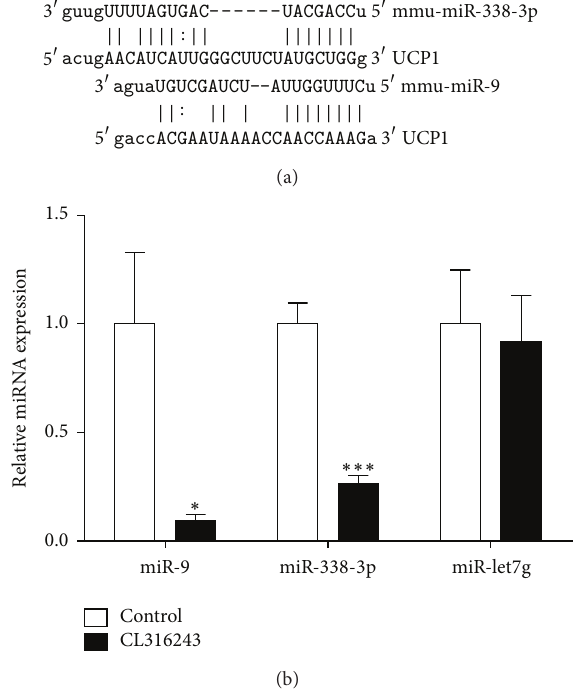
Figure 3: Analyses of mRNA expression of potential UCP1- targeting by qPCR in epididymal adipose tissue. (a) miRanda database predicts the binding site of UCP1 3 󸀠 UTR region of miR-9 and miR-338-3p. (b) mRNA expression of miR-9, miR-338-3p, and miR-let7g mRNA in epididymal adipose tissue ( 𝑛 = 7 each). Values are mean ± SEM; ∗ 𝑃 < 0.05 and ∗∗∗ 𝑃 < 0.001